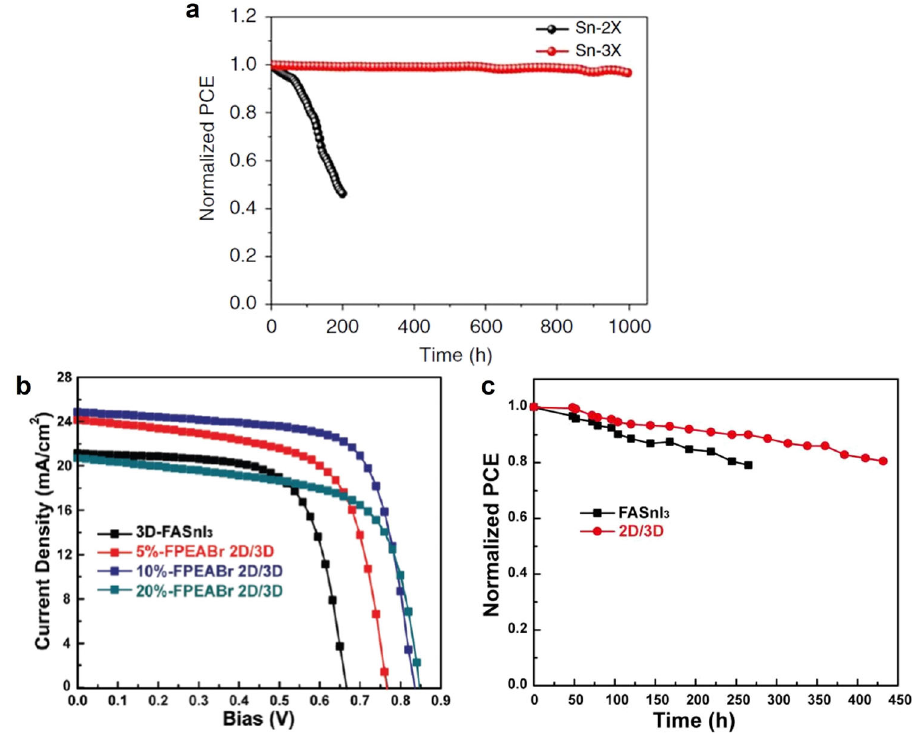
Fig. 3 Stability of 3D and 2D/3D Sn-HPSCs prepared with various additives. a The maximum power point (MPP) tracking of the unencapsulated devices with (Sn-3X) and without (Sn-2X) SnCl 2 addition. b Best current density – voltage ( J – V ) curves for pure 3D and 2D/3DSn-HPSCs with different FPEABr content. c Normalised PCE evolution of the 3D FASnI 3 and 2D/3D perovskite-based encapsulated devices in air (Fig. 3a adapted with permission from ref. 32 ,